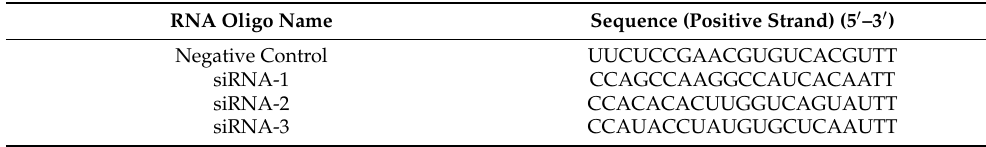
Table 1. Sequences of sense strand of siRNA against the target gene in